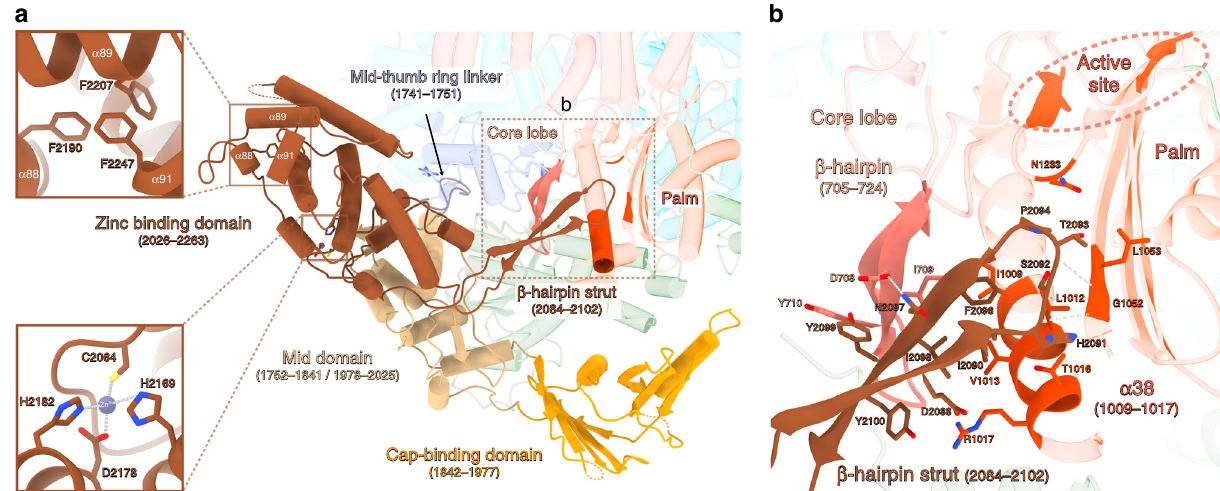
Fig. 4 C-terminal region of LACV-L FL. a The structure of LACV-L C-terminal region is shown as non-transparent, the rest of the polymerase is shown as transparent, except the residues interacting with the ZBD β -hairpin strut. The domains are colored as in Fig. 1. Position of the last α -helix 91 that interacts with α -helices 88/89 is indicated and a close-up view of hydrophobic amino acids interaction is shown. Close-up view on the coordination of the presumed zinc ion from the ZBD. Conserved residues implicated in ion coordination are shown and labeled. The ZBD β -hairpin strut that protrudes towards the core is surrounded by a dotted rectangle corresponding to panel b view. b Close-up view of the ZBD β -hairpin strut. Residues from the core lobe β -hairpin (705 – 724) and the palm domain that interact with the ZBD β -hairpin are indicated. The active site is surrounded by a dotted